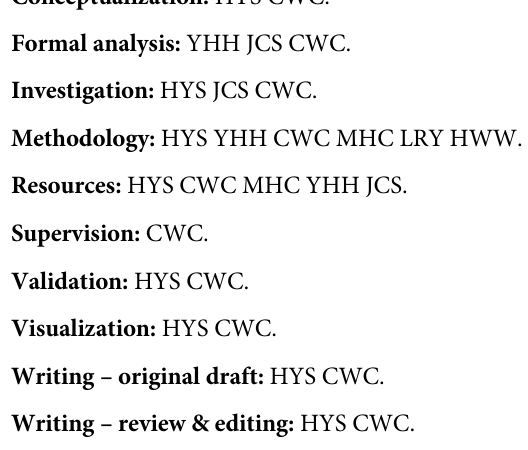
S1 Table. Demographical characteristics (age, gender, presence of hypertension, history of alcoholism and cigarette smoking) and polymorphism data of stroke patients and control